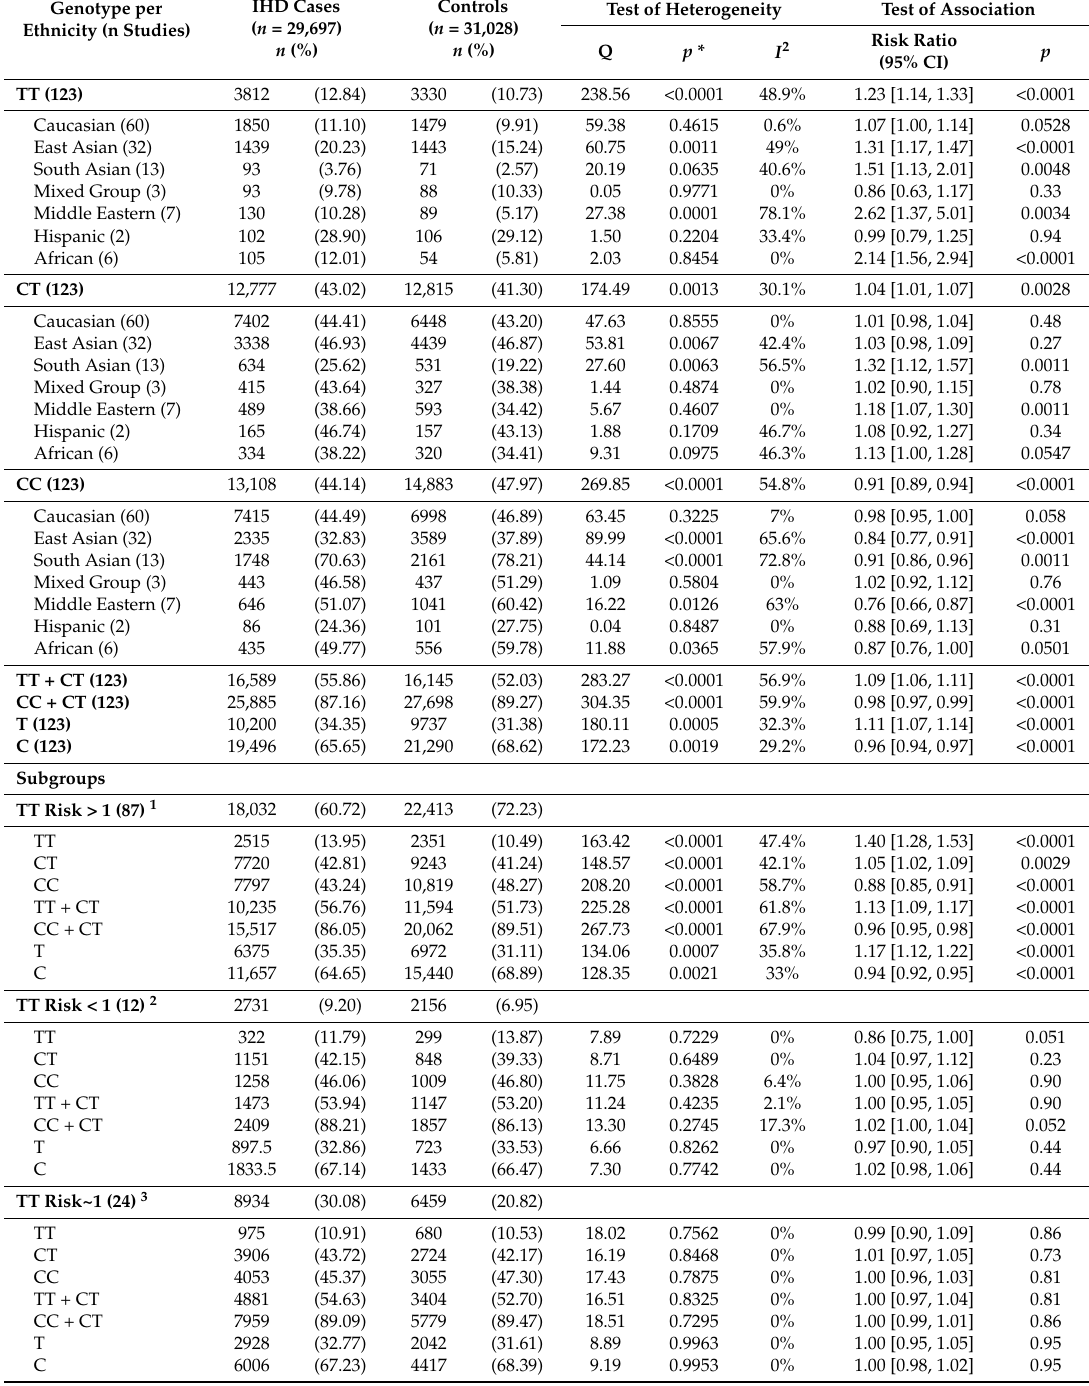
Table 2. Pooled analyses of MTHFR 677 genotypes and risks of ischemic heart disease (IHD) by ethnicity (123